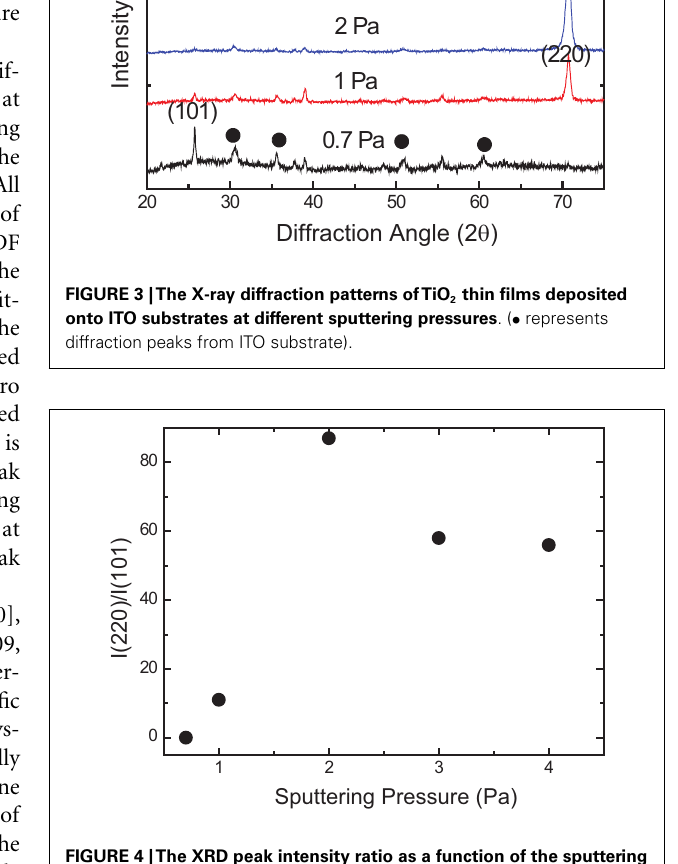
FIGURE 4 |The XRD peak intensity ratio as a function of the sputtering pressure